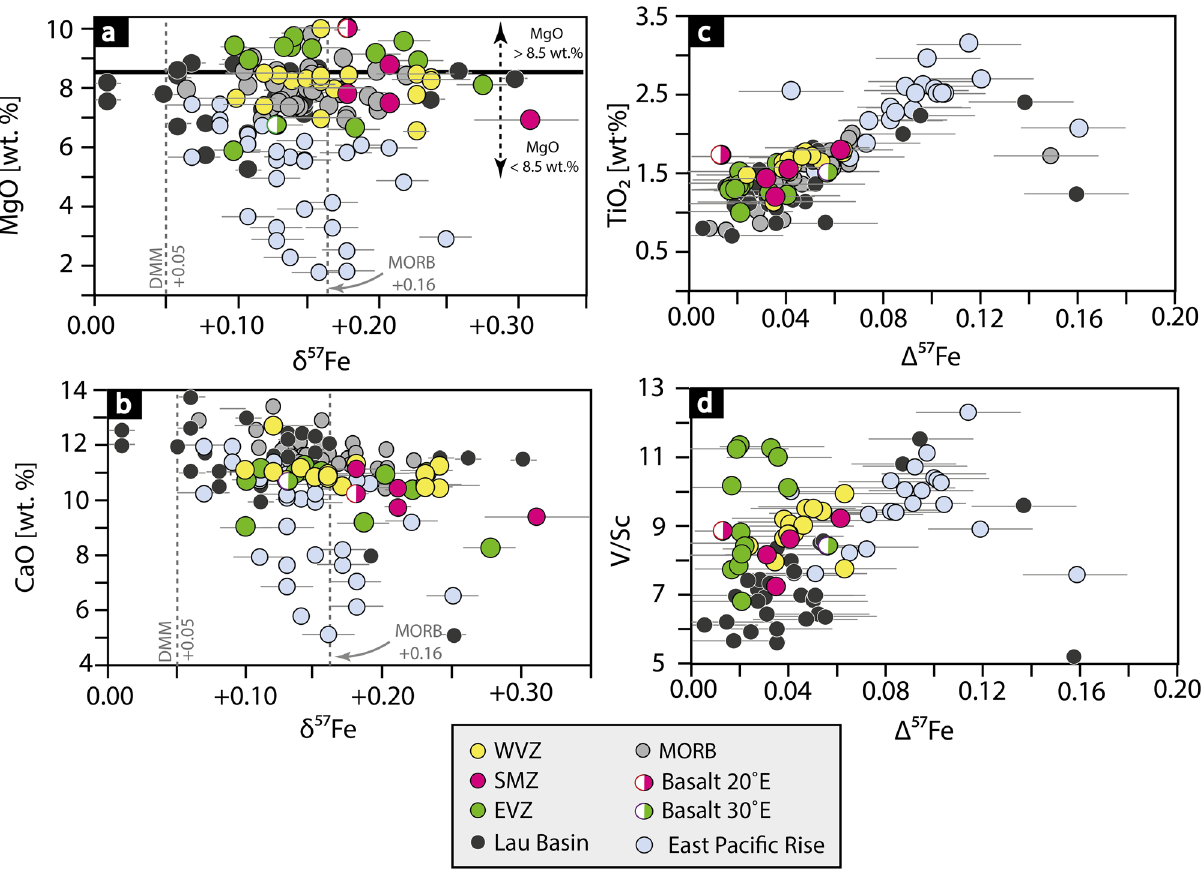
Figure 2. Major and trace elements versus iron isotope systematics. (a) MgO versus δ 57 Fe shows no obvious correlation. The black bold line marks the difference between the primitive (> 8.5 wt% MgO) and more evolved (< 8.5 wt% MgO) Gakkel basalts. (b) CaO versus δ 57 Fe. Gakkel Ridge lavas have lower CaO values compared to MORBs globally. (c) TiO 2 versus Δ 57 Fe (Δ 57 Fe = δ 57 Fe − δ 57 Fe prim ; see text for detailed description). Δ 57 Fe is used here as an indicator for crystal fractionation with larger values marking higher degrees of fractionation. The major element values show a positive correlation with increasing isotope fractionation (for Δ 57 Fe < 0.12 ‰). Advanced isotope fractionation (Δ 57 Fe > 0.12 ‰) shows a negative correlation with TiO 2 . (d) V/Sc versus Δ 57 Fe shows similar behaviour with increasing isotopic fractionation as TiO 2 . Basalts from the EVZ, however, do not follow this trend and scatter at around Δ 57 Fe = 0.02–0.03 ‰. MORB data are compiled from Teng et al. 25 , Weyer et al. 45 and Chen et al. 49 ; East Pacific Rise data from Chen et al. 48 , and data from the Lau Basin from Nebel et al. 40 are used here for